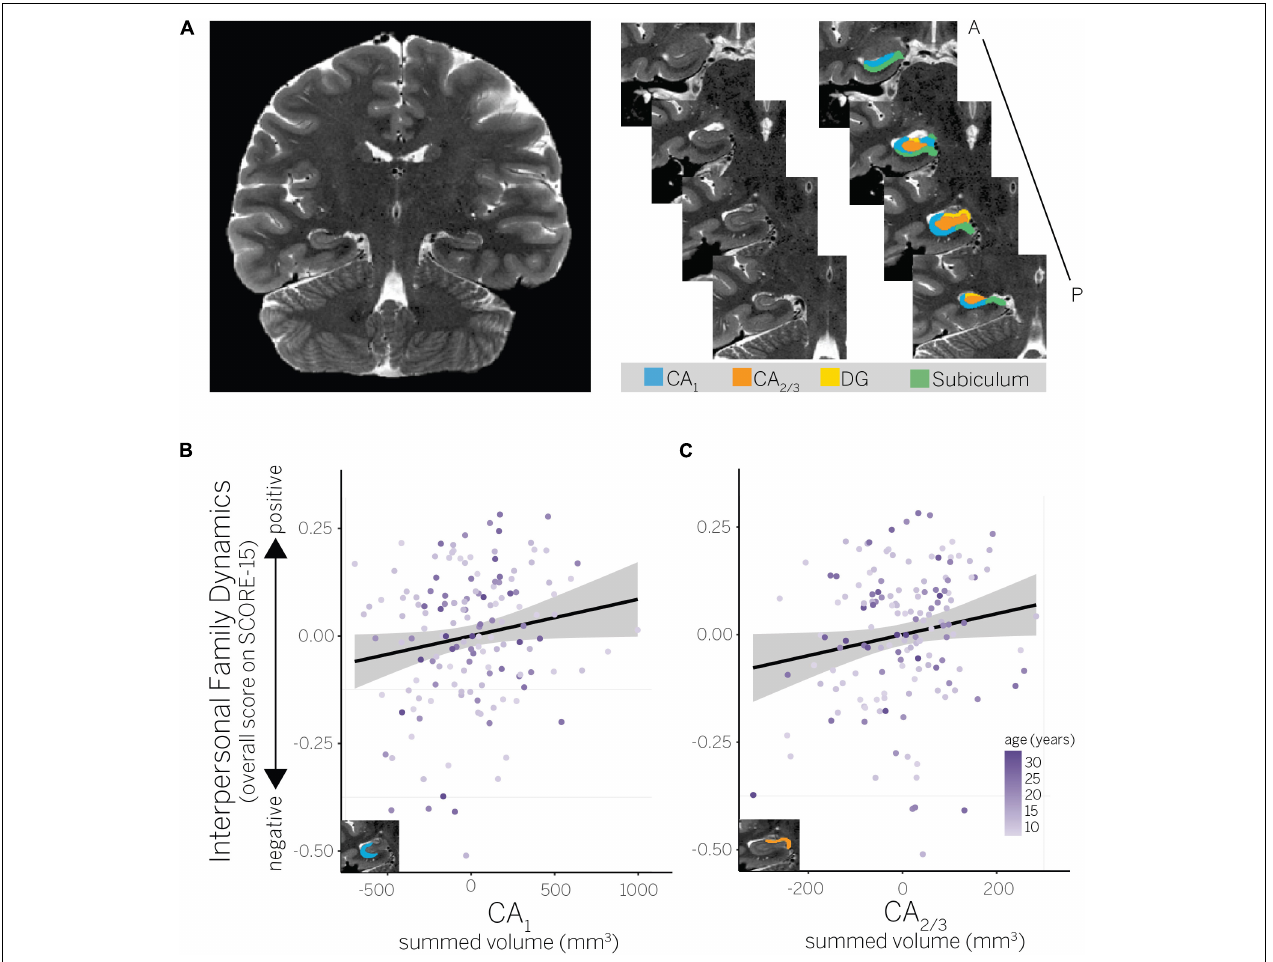
FIGURE 2 | (A) Example hippocampal subfield ROIs (CA 1 , CA 2 / 3 , dentate gyrus, and subiculum) for a representative child participant. ROIs are shown on the right hemisphere, but were summed bilaterally for all analyses. (B) Partial residual plot showing association between perceived interpersonal family dynamics and CA 1 volume, and (C) interpersonal family dynamics and CA 2 / 3